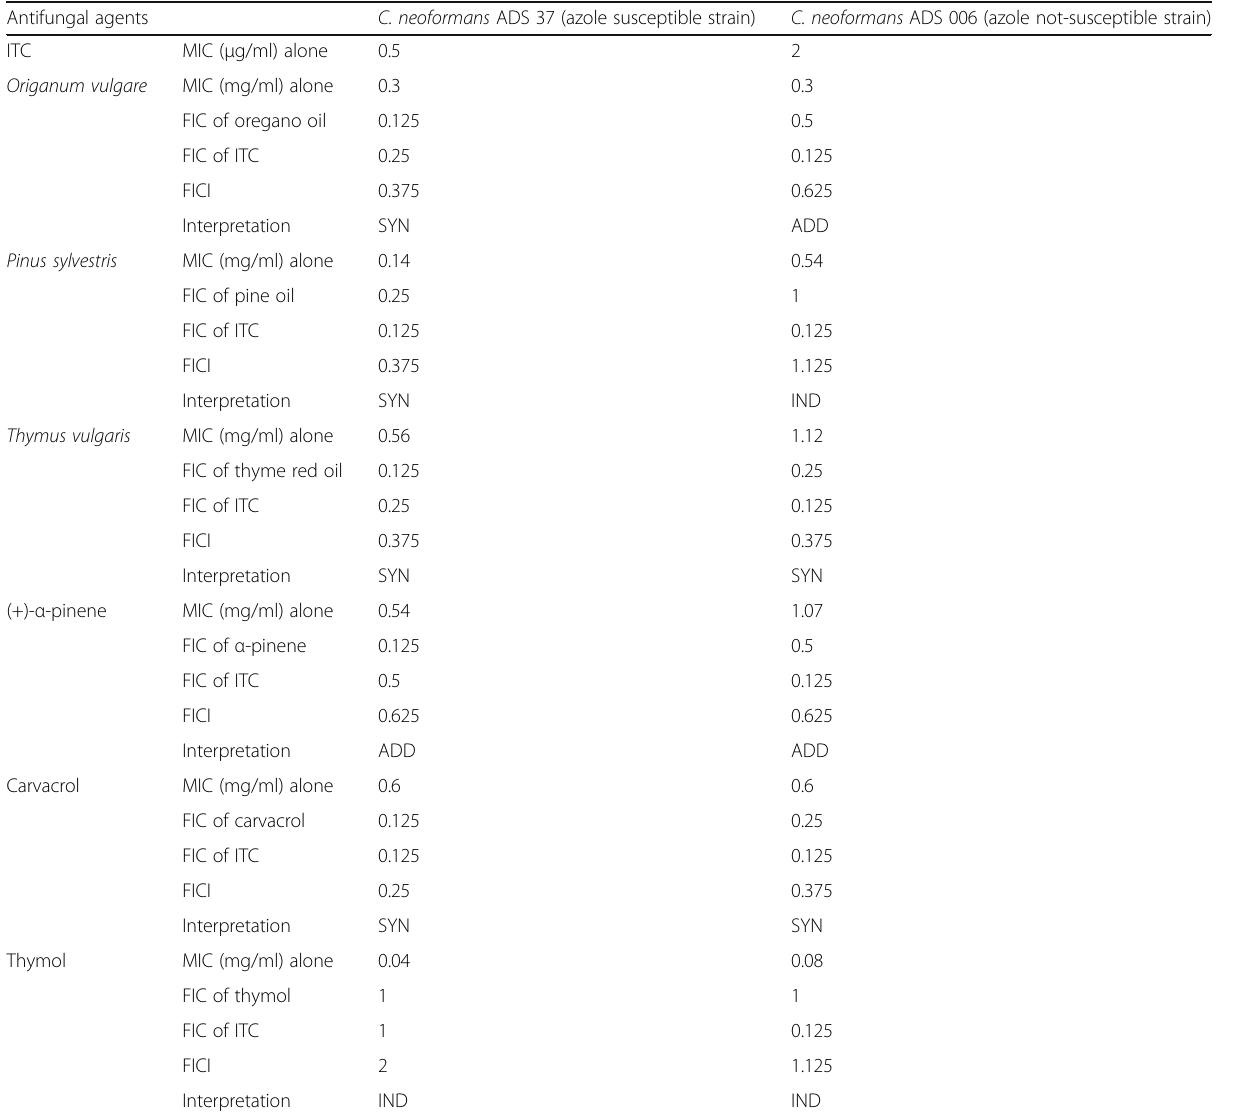
Table 3 Fractional inhibitory concentration index (FICI) of essential oils plus itraconazole Antifungal